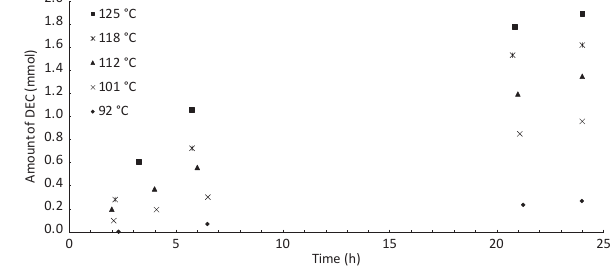
Figure 5: Evolution of amount of DEC produced as a function of time for different reactor temperatures.